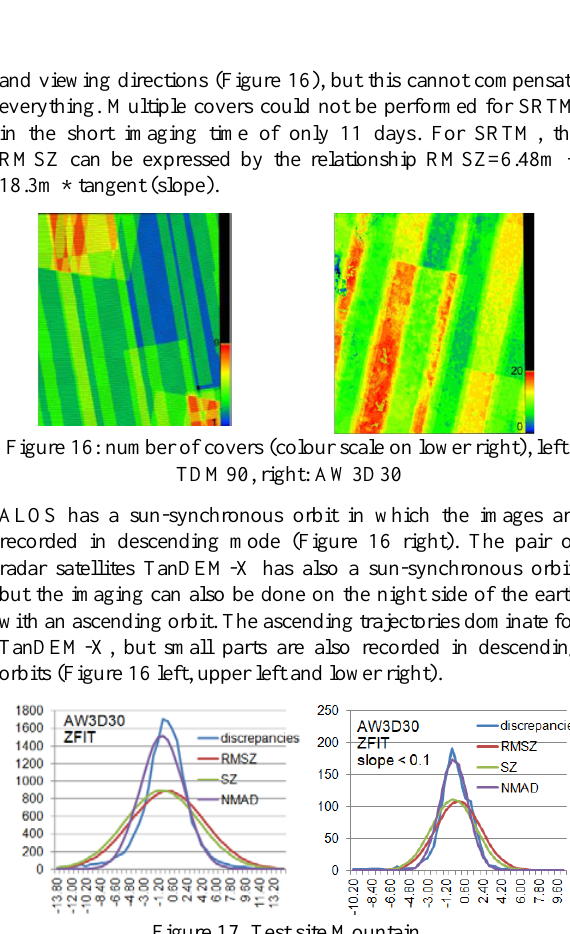
Figure 17. Test site Mountain, Frequency distribution AW3D30 with ZFIT